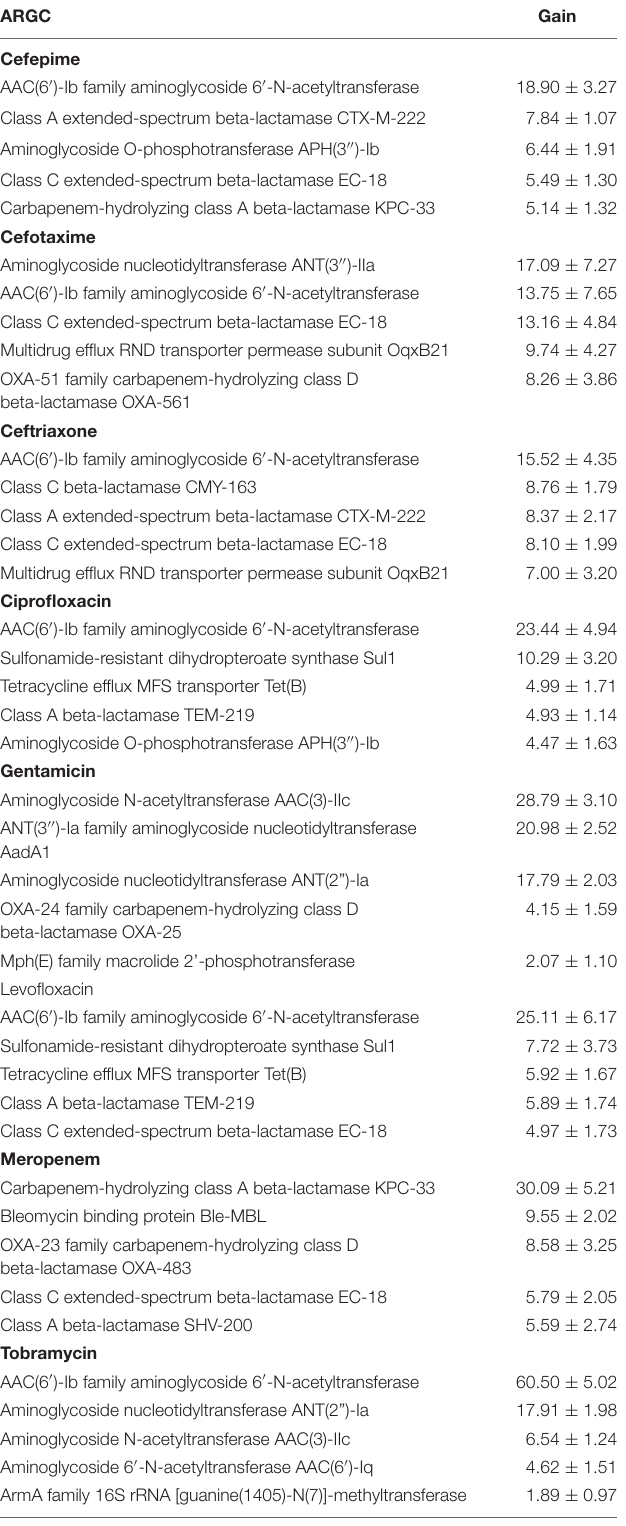
TABLE 4 | Top 5 most important features for each antibiotic model. TABLE 5 | Counts of unique features found among top 5 across 51 independent models for each